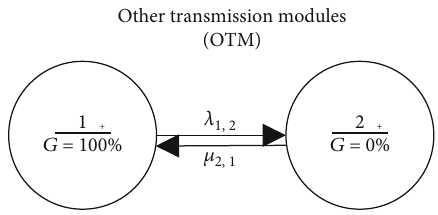
Figure 6: State-transition diagram of other transmission modules.